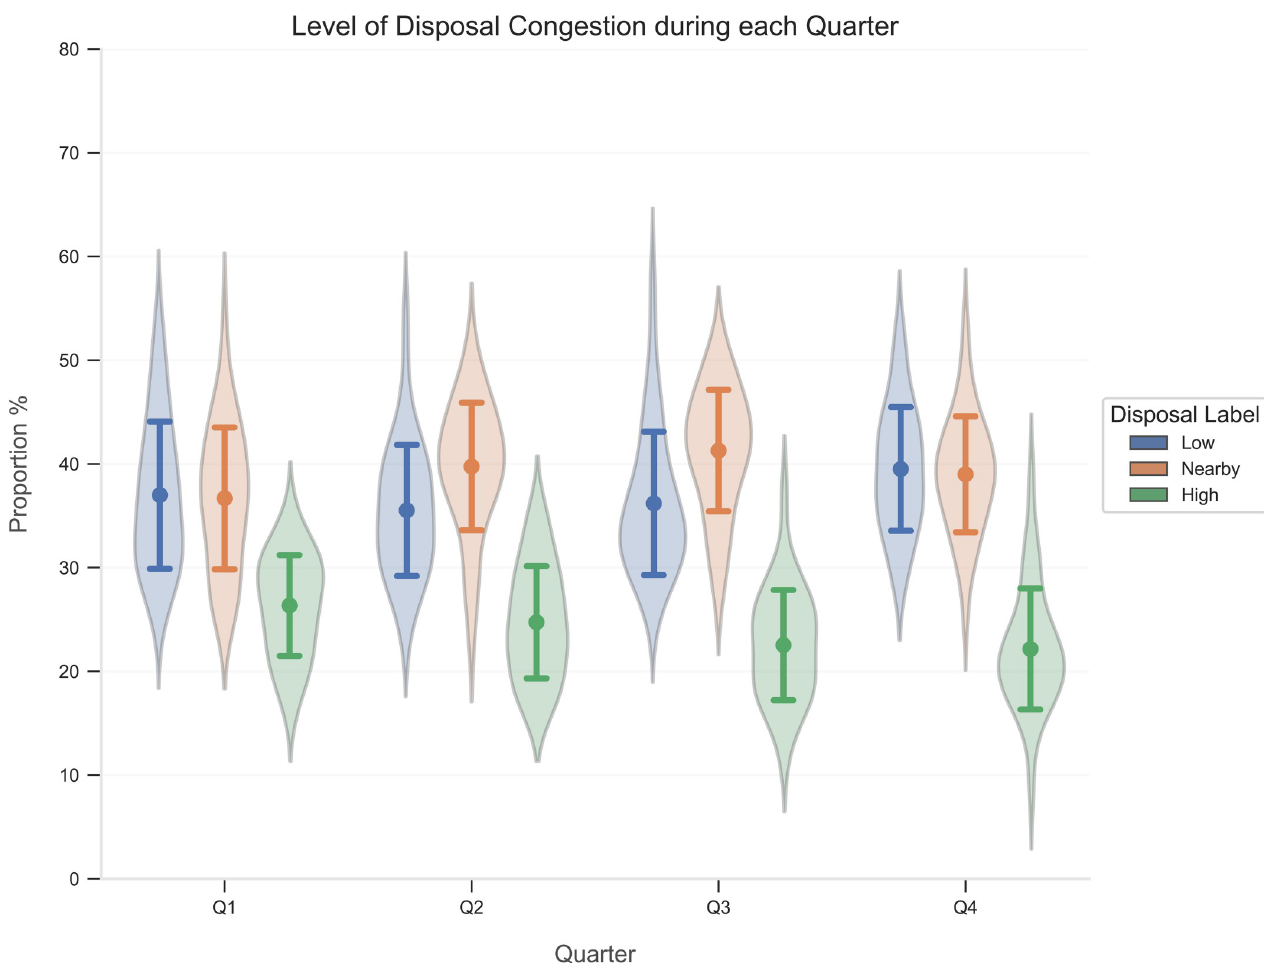
Fig 8. Breakdown of disposals (mean ± standard deviation) in each level of congestion compared across quarter in the 2019 and 2021 season. Q1, Quarter 1; Q2, Quarter 2; Q3, Quarter 3; Q4, Quarter 4.